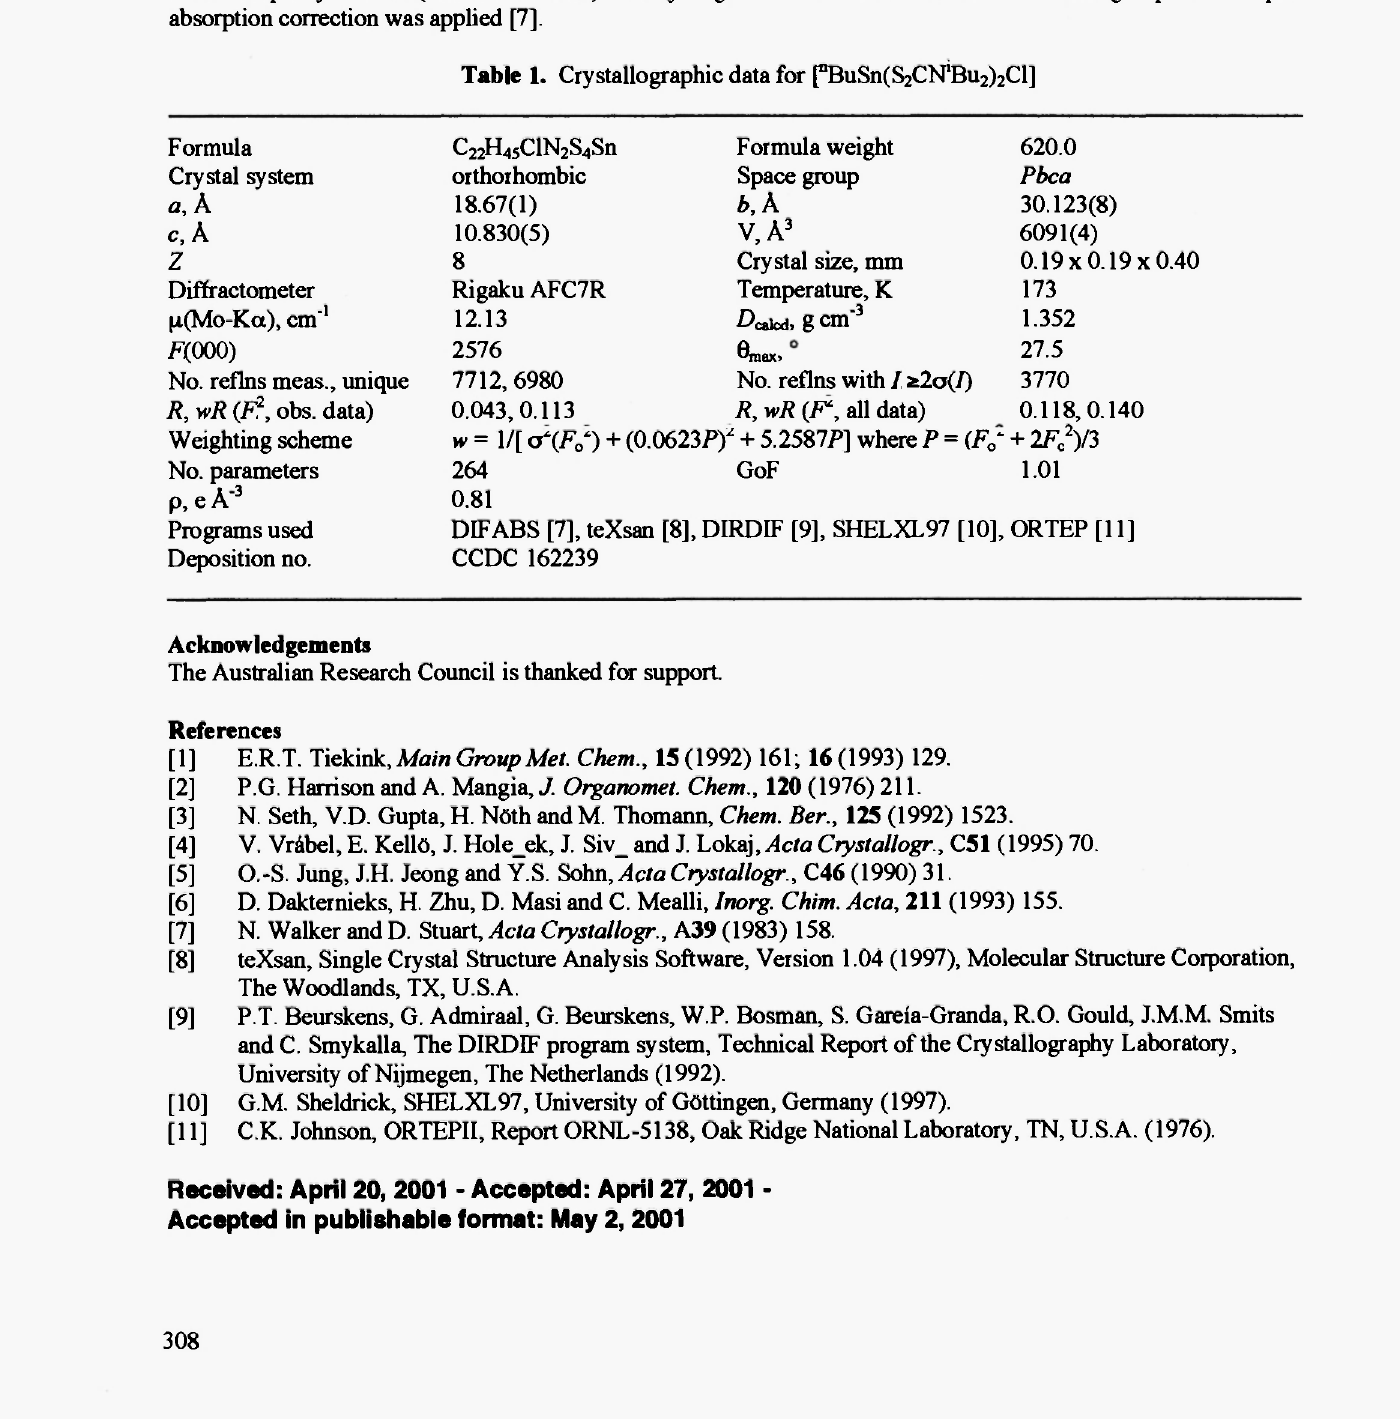
Table 1. Crystallographic data for fBuSn(S